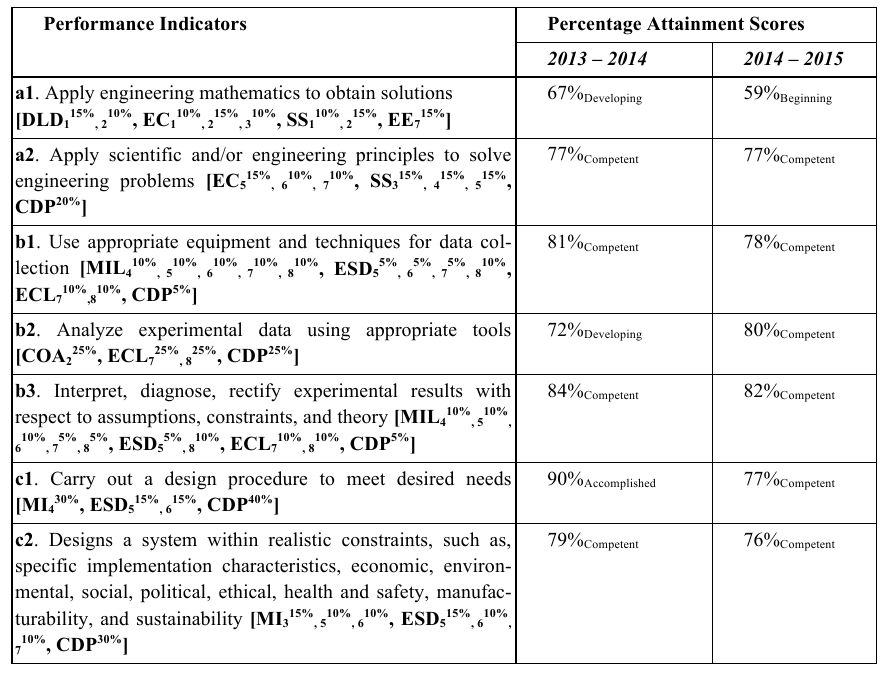
Table 1. PIs, their weighted mapping to course CLOs, where the subscript indicates the CLP number and superscript indicates the weight, and the attainment scores over two asses- sment cycles over two